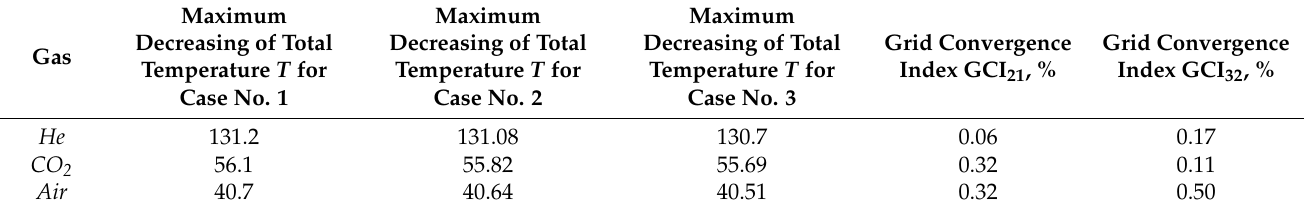
Figure 14. The contour of y + obtained for SVT with ( a ) air ; ( b ) He ; and ( c ) CO 2 . The mesh independence study showed a negligible effect on the control parameter (Table 8). Following the GCI parameter, its maximum value was 0.5% and was obtained for SVT with air. Table 8. Mesh independence study results for SVT with the same Reynolds number.